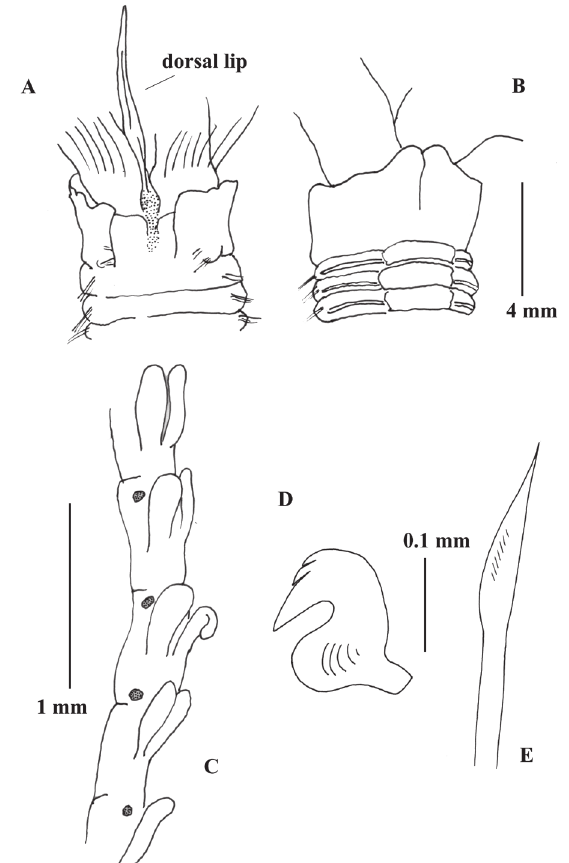
Fig . 6. – Branchiomma sp.: A, anterior end, dorsal view; B, anterior end, ventral view; C, detail of radiole showing stylodes and radiolar eyes; D, thoracic uncinus; E, thoracic inferior notochaeta.